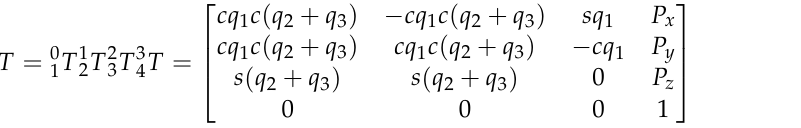
Figure 7. Kinematic model of walking leg. The D-H parameters of the walking leg are shown in Table 1. l 1 , l 2 , and l are the lengths of each link of the walking leg. θ 1 , θ 2 , and θ 3 are the rotation angles of each joint. q 1 = θ 1 ,